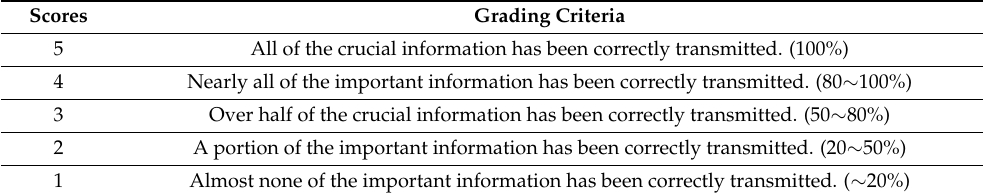
Table 7. The specificities of the JPO adequacy